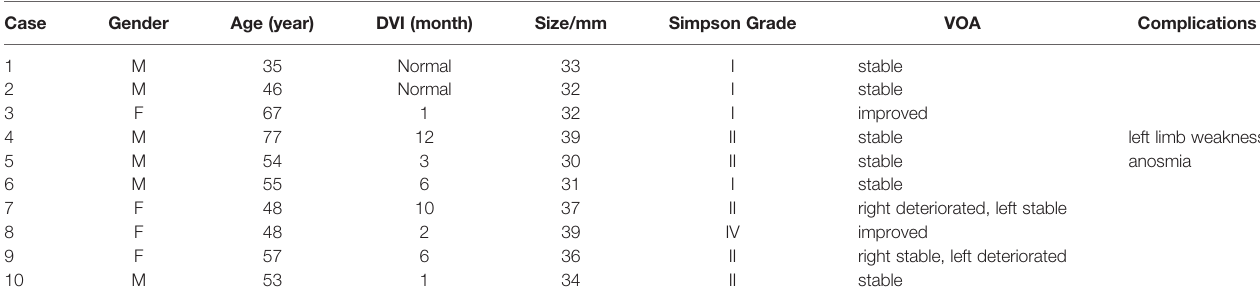
TABLE 1 | Clinical characteristics of patients and